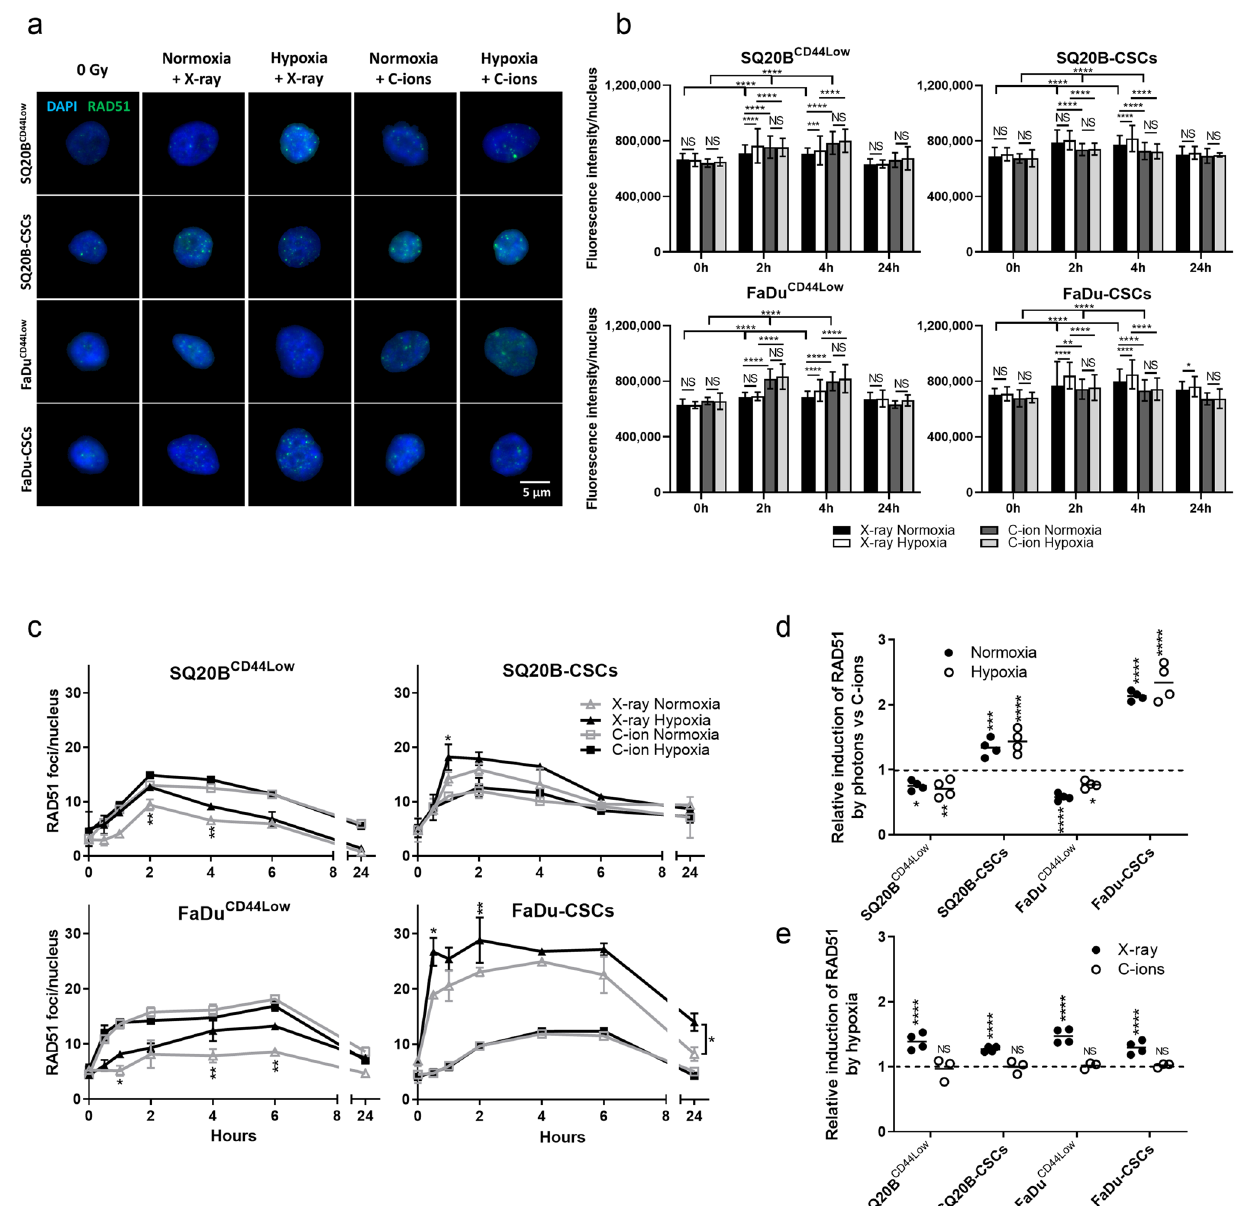
Figure 7. Hypoxia enhances the homologous recombination pathway after photons whereas C-ions act independently of the oxygen concentration. ( a ) Representative images of RAD51 foci at the peak after X-ray or C-ion irradiation in normoxic and hypoxic conditions for the four subpopulations studied (Metafer 4 v3.13.4). ( b ) RAD51 fluorescence intensities. The means of the fluorescence intensities between different oxygenation conditions were compared for both types of irradiation, as well as the induction of RAD51 by irradiation with the 0 h condition (two-way ANOVA test). ( c ) Kinetics of RAD51 foci induction and decay from 30 min to 24 h after X-ray and C-ion irradiation in normoxic and hypoxic conditions. The symbols indicate means and the error bars indicate SD values. The means of the different oxygenation conditions were compared for both irradiations (two-tailed Student’s t-test).( d ) Relative induction of the RAD51 foci peak in response to photons compared with C-ions for each condition of irradiation and oxygenation, as determined from the data shown in ( c ) (two-way ANOVA test). ( e ) Relative induction of the RAD51 foci peak in response to hypoxia for each condition of irradiation, as determined from the data shown in ( c ) (two-way ANOVA test). * P < 0.05, ** P < 0.01, *** P < 0.001, **** P < 0.0001 (n =